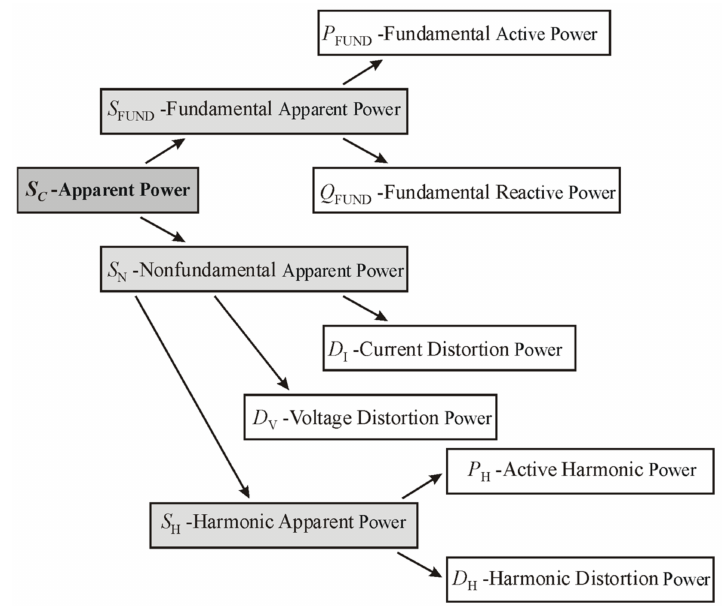
Figure 4. The power management organization according to the IEEE1459. Table 1. Power components at the point of connection of Siemens Micromaster 420 single-phase